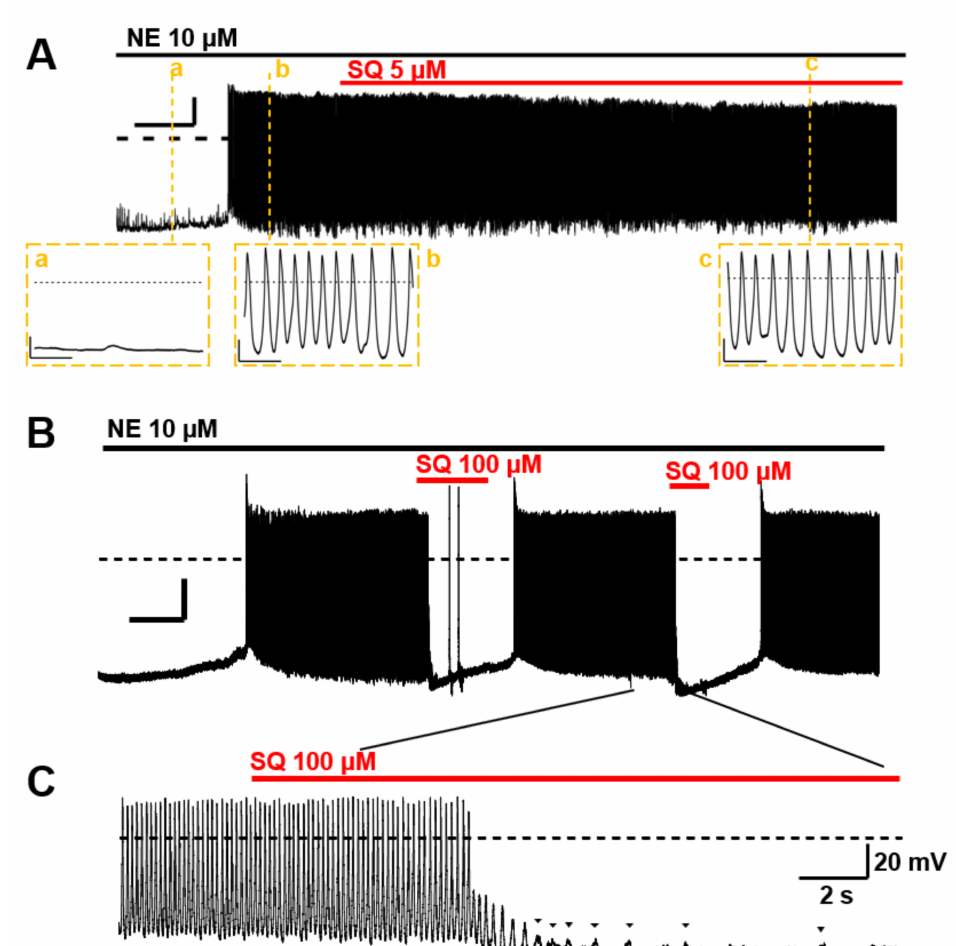
Figure 8. Effects of SQ22536 (SQ) on the norepinephrine (NE)-induced automaticity of pulmonary vein (PV). ( A ) An example of NE-induced spontaneous automaticity. NE 10 µ M evoked a series of action potentials in isolated rat PV cardiomyocytes. The action potentials recorded at a, b, and c are displayed in an expanded time scale below. Inserted time and voltage scales indicate 50 s and 20 mV, respectively. The time scale in the expanded view indicates 500 ms. The induced automaticity was uninhibited by 5 µ M SQ. ( B ) The induced automaticity was reversibly suppressed by 100 µ M SQ. Inserted time and voltage scales indicate 50 s and 20 mV, respectively. The time course of the inhibition is expanded in ( C ). The sporadic depolarizations corresponding to Ca 2+ release were gradually attenuated (arrowheads). Similar results were confirmed four times ( n = 4, for each). The timing and duration of drug applications are indicated by horizontal bars. A dashed line indicates the